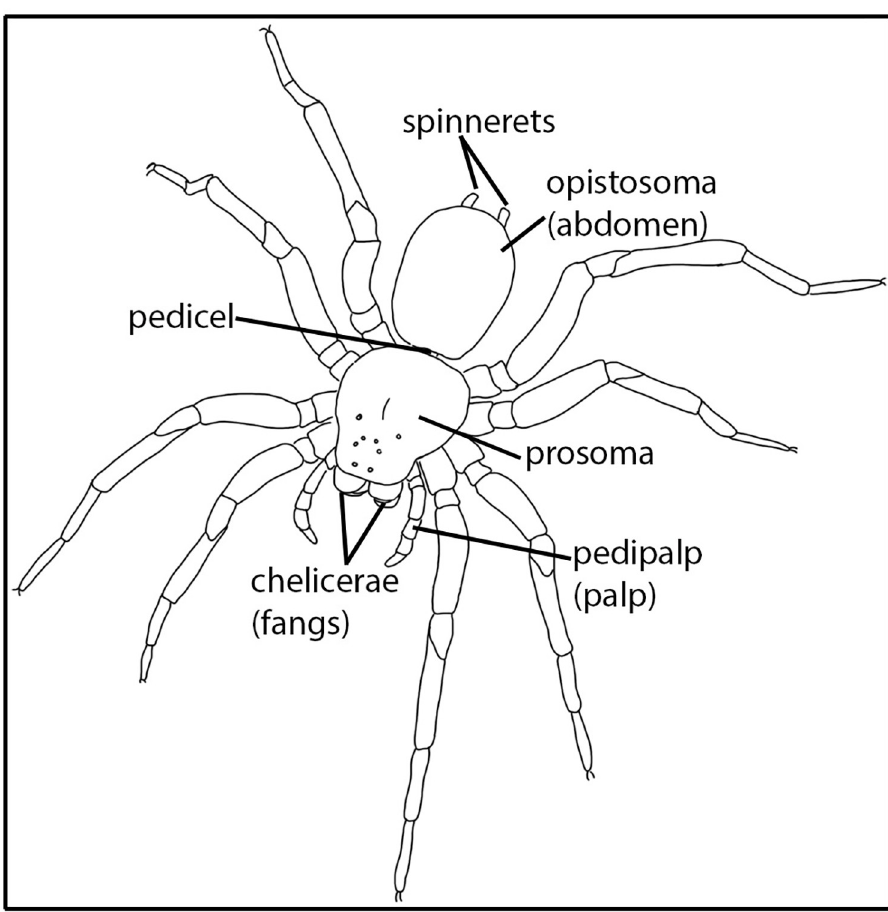
Fig 5. Spider (order Araneae) illustration. Body parts discussed in text are